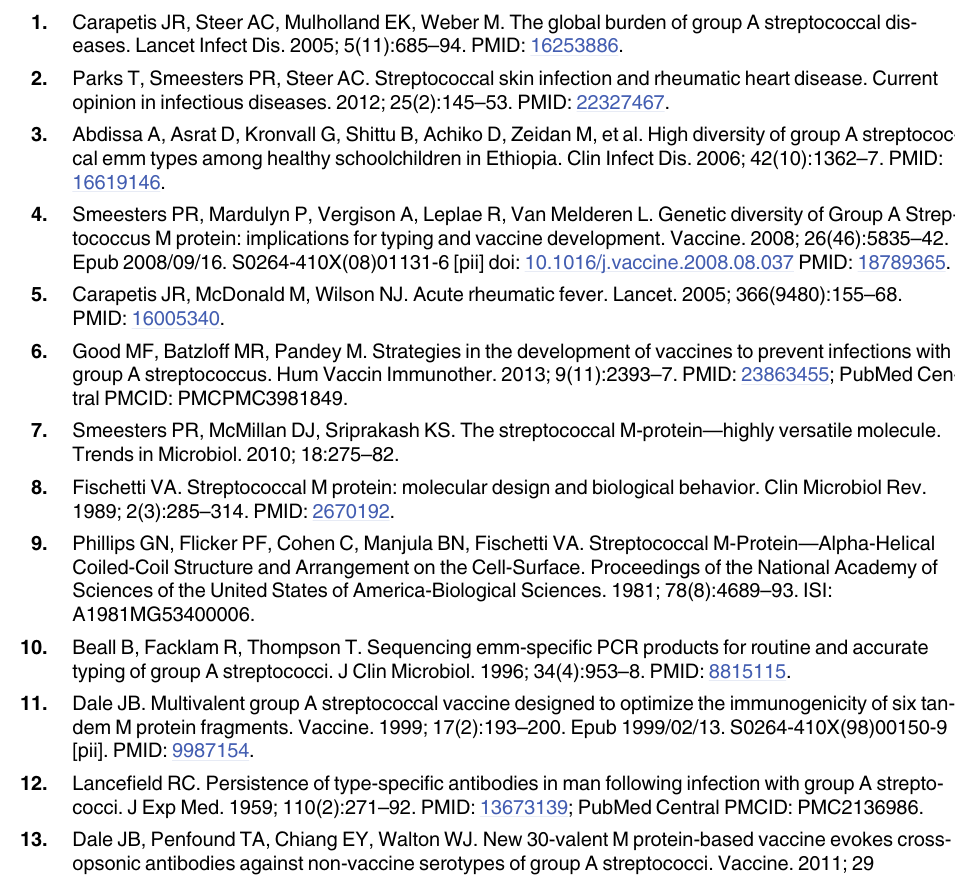
variants in GAS i